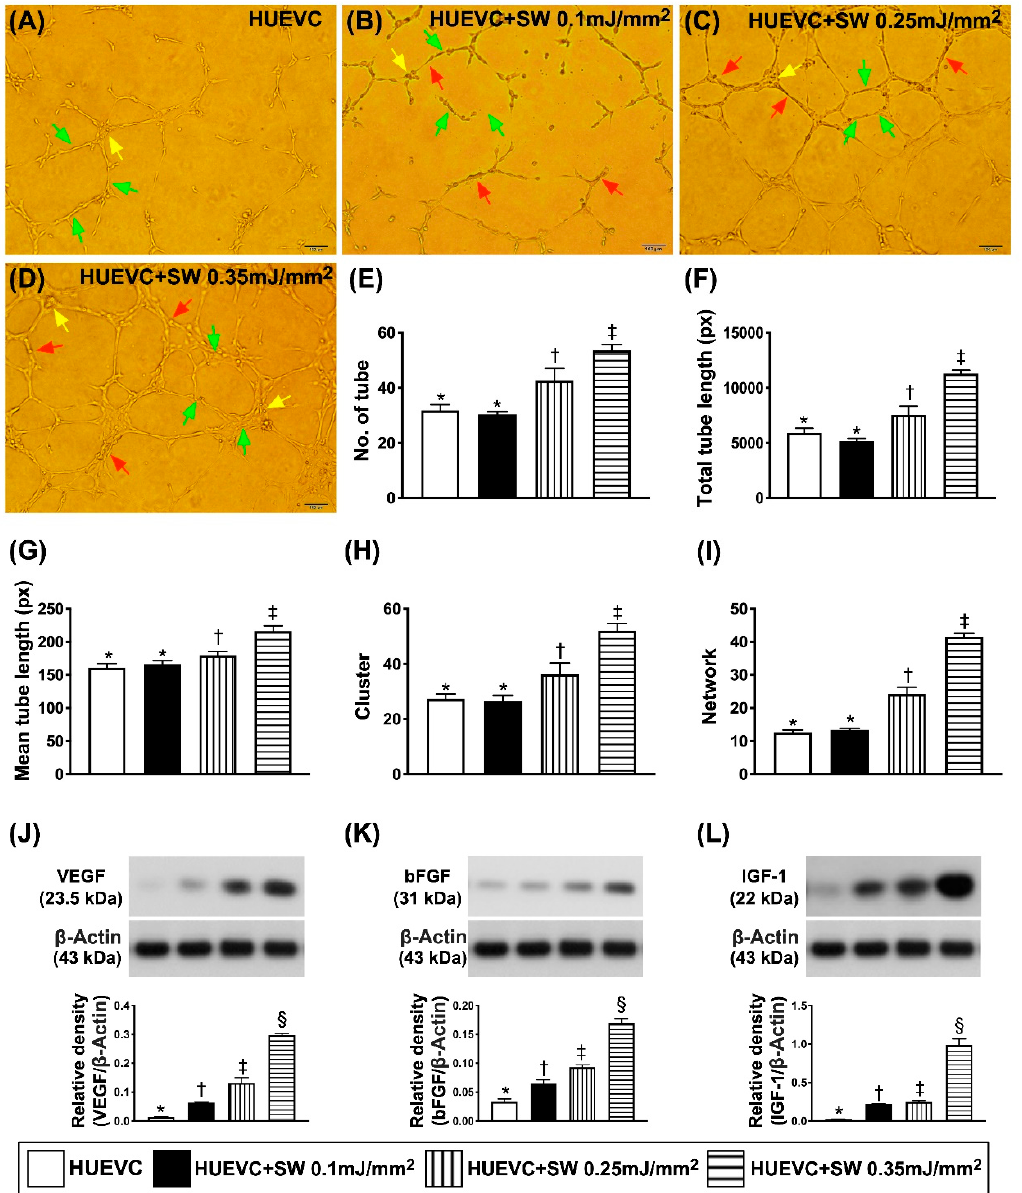
Figure 1. A positive correlation between increased ECSW energy and increased angiogenesis from both HUVECs and ADMSCs. ( A – D ) Illustrating (100×) the Matrigel assay for identification of a stepwise increase in ECSW dosages and upregulated capacity of angiogenesis in human umbilical vein endothelial cells (HUVECs). The parameters of angiogenesis, including: (1) tubular formation (red arrows), (2) cluster formation (yellow arrows) and (3) network formation (green color). Scale bar in right lower corner represents 100 µ m. ( E ) Analytical result of number of tubules, * vs. other groups with different symbols (†, ‡), p < 0.001. ( F ) Analytical result of total tubular length, * vs. other groups with different symbols (†, ‡), p < 0.001. ( G ) Analytical result of mean tubular length, * vs. other groups with different symbols (†, ‡), p < 0.001. ( H ) Analytical result of cluster formation * vs. other groups with different symbols (†, ‡), p < 0.001. ( I ) Analytical result of network formation, * vs. other groups with different symbols (†, ‡), p < 0.001. ( J ) Protein expression of vascular endothelial growth factor (VEGF) in ADMSCs, * vs. other groups with different symbols (†, ‡, §), p < 0.001. ( K ) Protein expression of basic fi broblast growth factor (bFGF) in ADMSCs, * vs. other groups with di ff erent symbols (†, ‡, §), p < 0.001. ( L ) Protein expression of insulin-like growth factor (IGF)-1 in ADMSCs, * vs. other groups with di ff erent symbols (†, ‡, §), p < 0.001. All statistical analyses were performed by one-way ANOVA, followed by Bonferroni multiple comparison post hoc test ( n = 6 for each group). ADMSCs = adipose-derived mesenchymal stem cells; SW = shock wave.